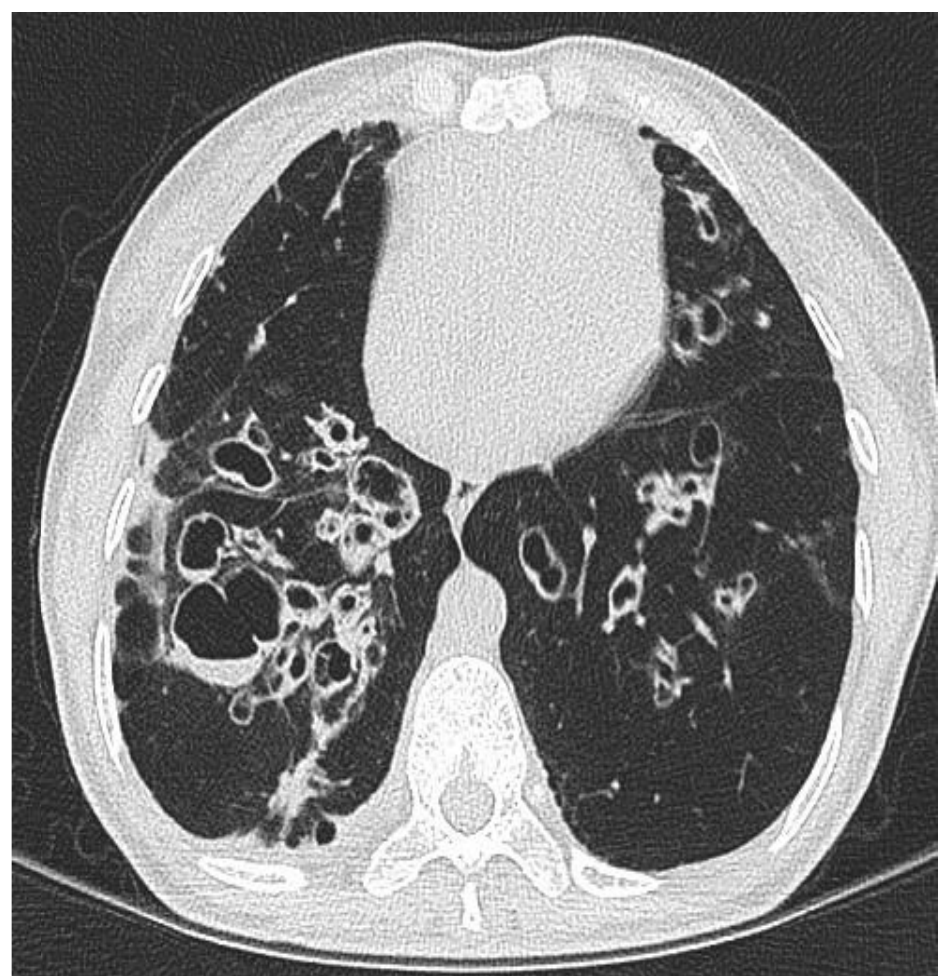
Figure 2. Computed tomography demonstrating cystic bronchiectasis in a patient with idiopathic bronchiectasis.